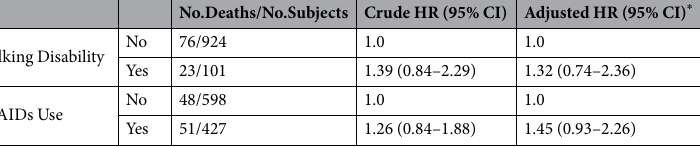
Table 2. Walking Disability, Use of NSAIDs and All-Cause Mortality. * Adjusting for age, sex, BMI, education, income level, level of daily physical activity, comorbidities, and knee SxOA.